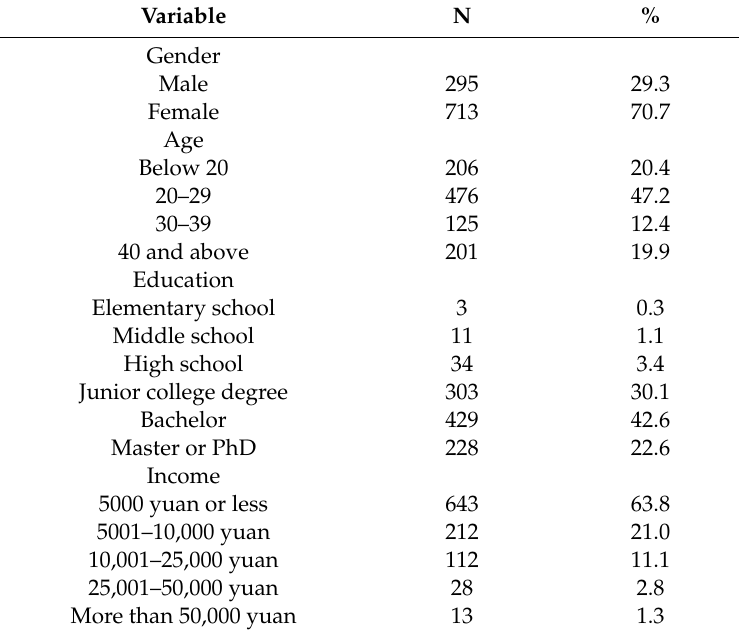
Table 1. Socio-demographic profiles of the